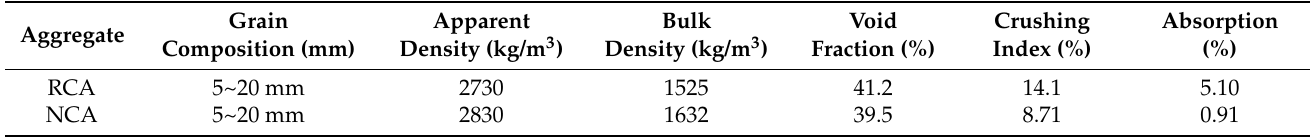
Table 1. Technical properties of coarse